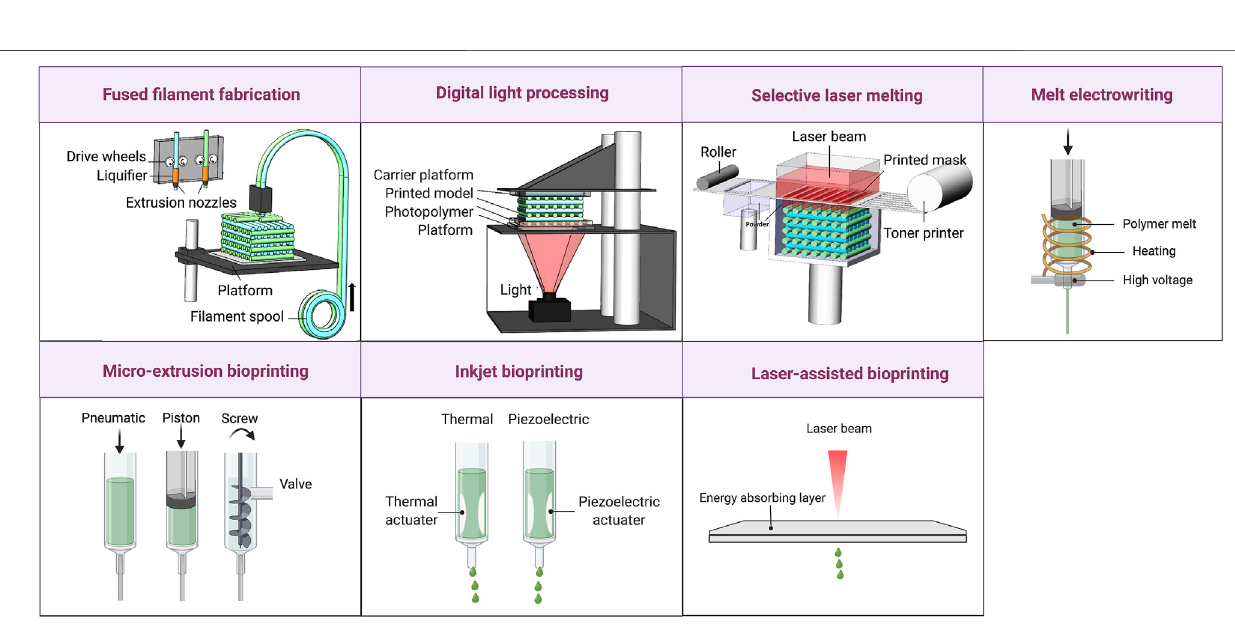
Frontiers in Bioengineering and Biotechnology |